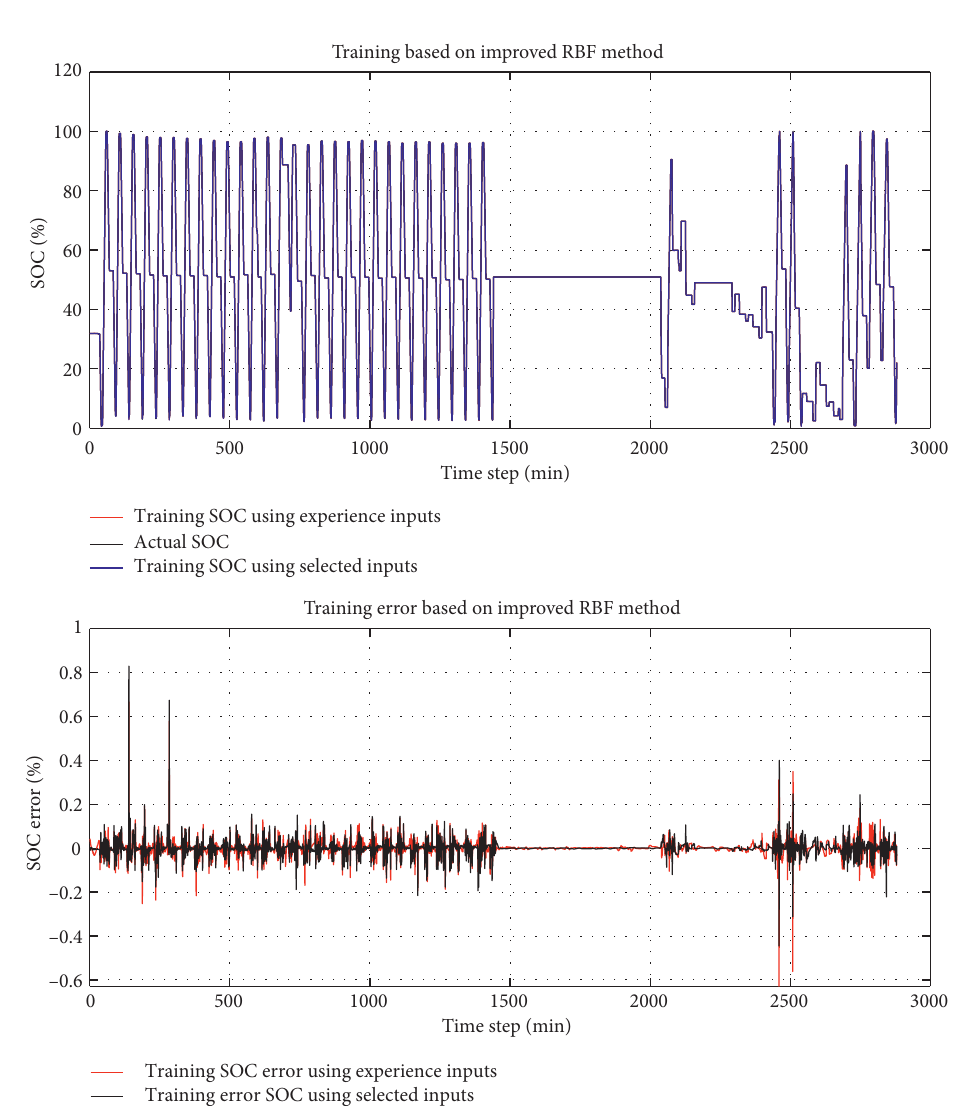
Figure 2: Training results for different model inputs using proposed